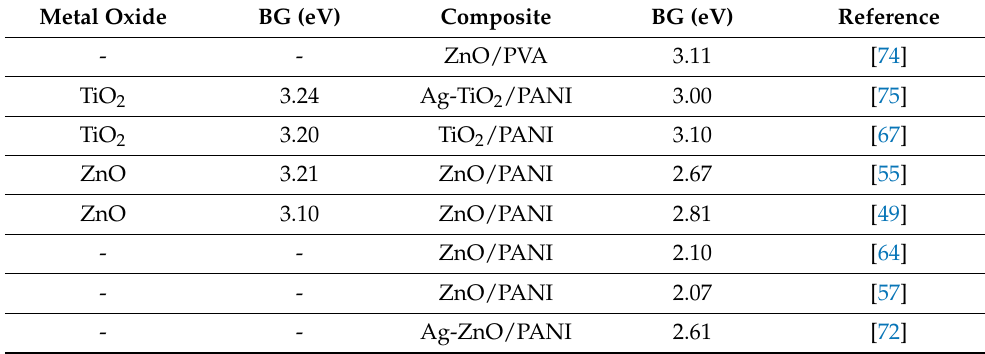
Table 6. Band gap values for different catalytic materials.